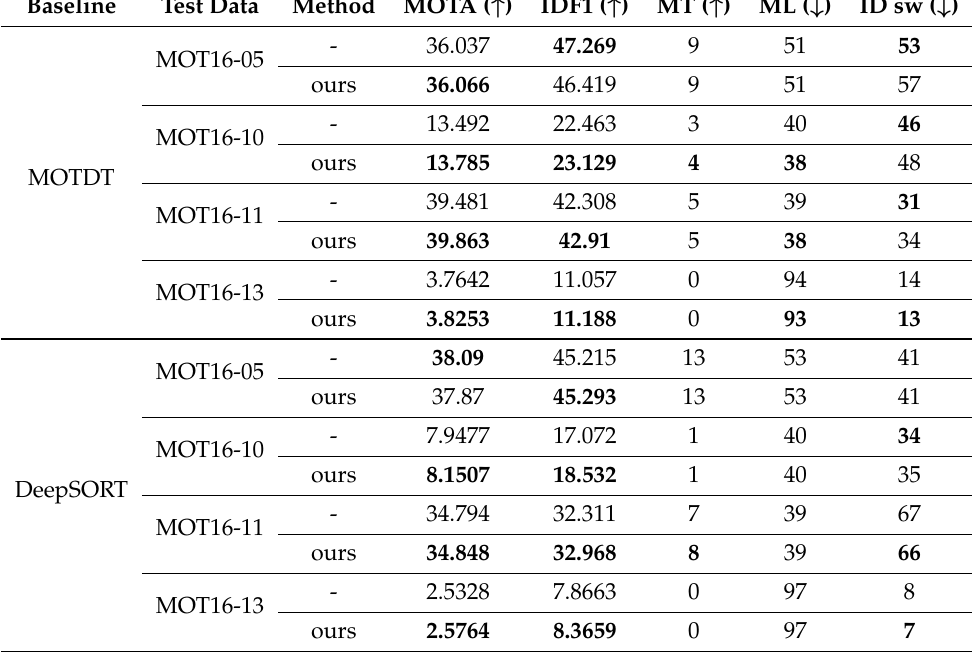
Table 3. Experimental results to confirm the effect of the proposed model applied to an unfamiliar environment. The parameters found through the previous experiment are used without change, and the MOT Challenge dataset is used as a test set. Highlighting represents better performance. Baseline Test